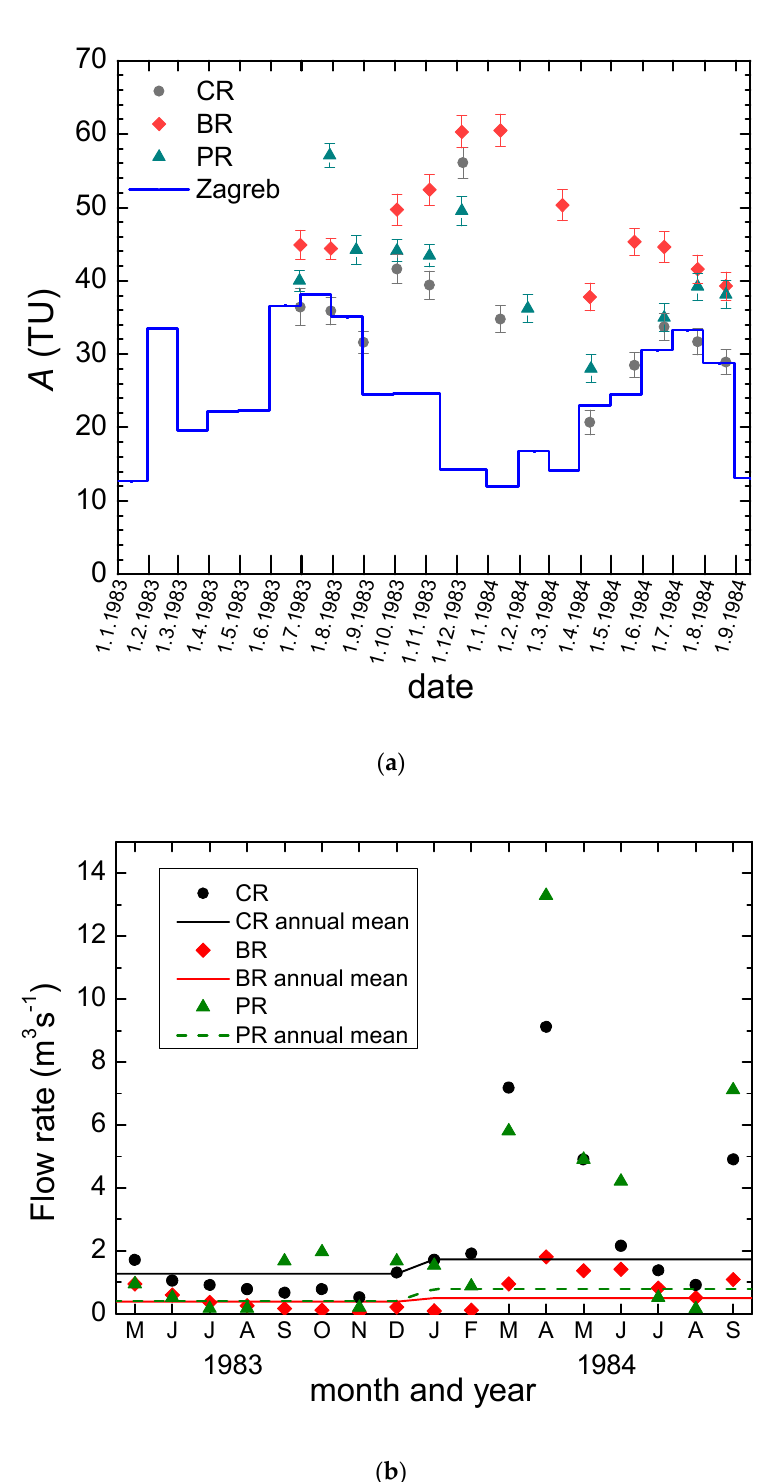
Figure 12. ( a ) Tritium activity concentration in the CR, BR, and PR springs in 1983 and 1984, when extreme hydro-meteorological conditions appeared; ( b ) flow rates at the CR, BR, and PR springs during 1983–1984. Symbols refer to the maximal flow rates in respective months, and lines represent the mean annual flow rates in 1983 and 1984.